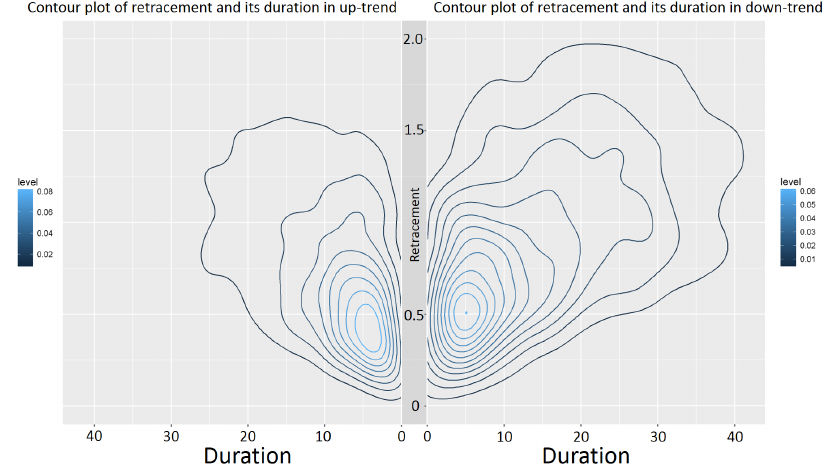
Figure 9. Contour plot of the joint density of the retracement value and its duration in up- and down-trends (left and right resp.) with scaling one for S&P100